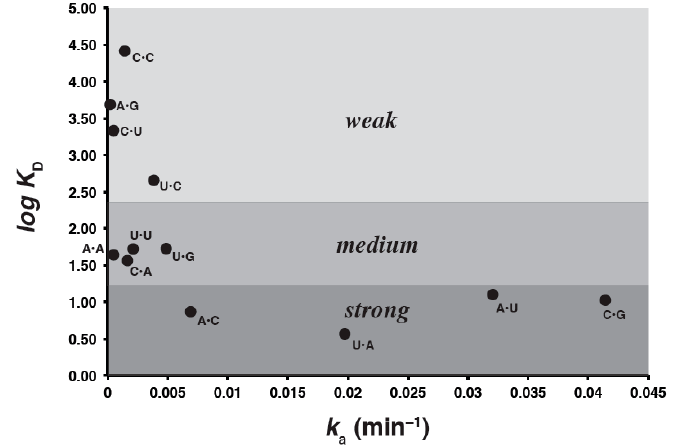
Figure 3. Plot of log (measured binding strength) as a function of autocatalytic rate constant. The untransformed values of these two parameters are only weakly negatively correlated ( r 2 = 0.74) but the rank orders are significant ( p = 0.0057; Spearman’s rank-order correlation test). Visually, three discrete bins of IGS-tag binding strength can be observed.